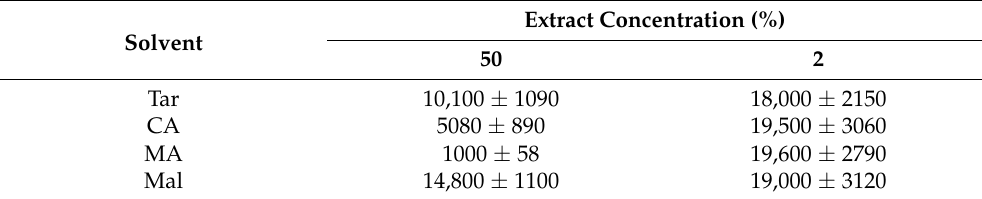
Table 4. The number of bacterial cells of Bacillus brevis in solution (c/mL) when different extracts (initial number, 20,000 c/mL) are used.